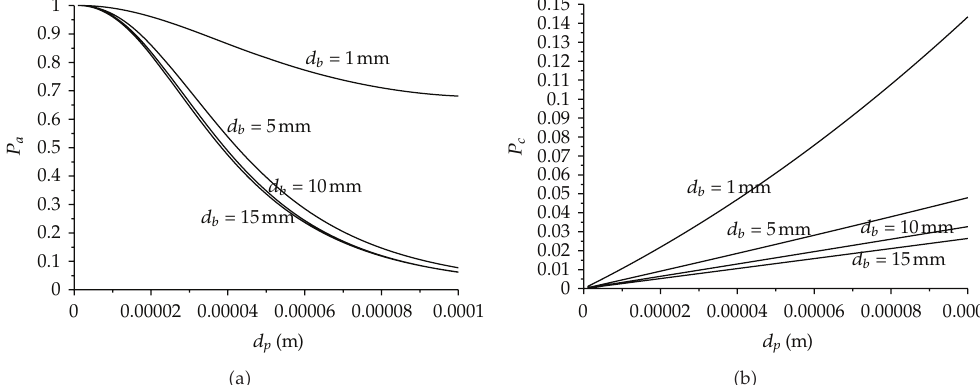
Figure 3: (cid:4) a (cid:5) Attachment Probability and (cid:4) b (cid:5) Collision